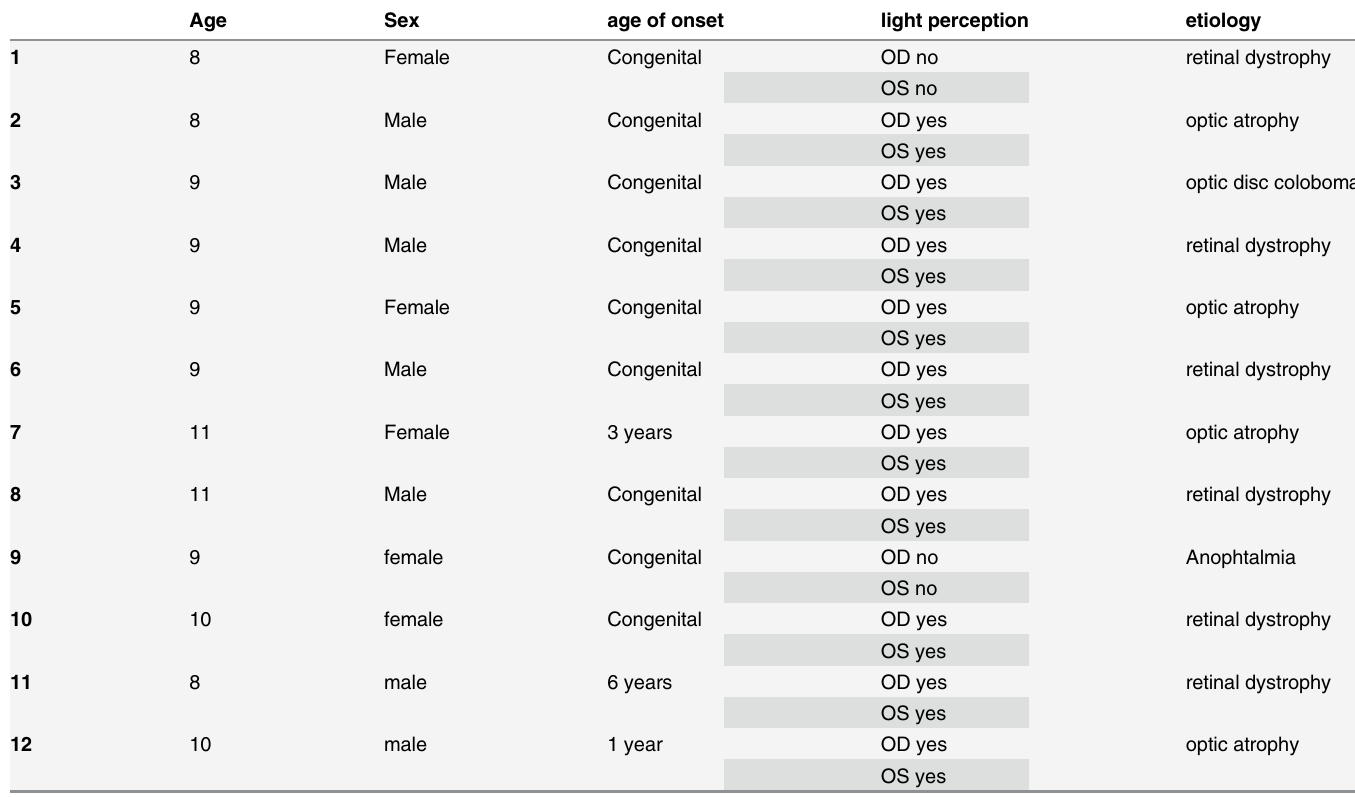
Table 1. Demographic Characteristics of Children with